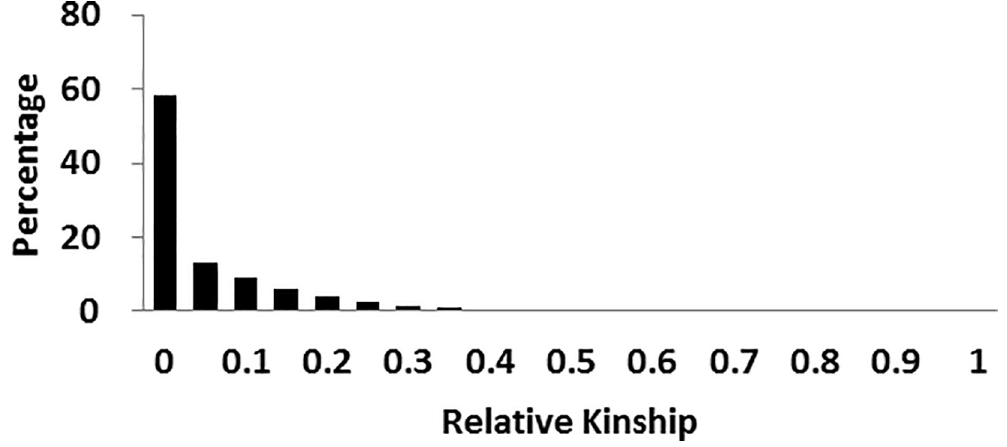
Fig 2. Distribution of pairwise relative kinship among 120 inbred